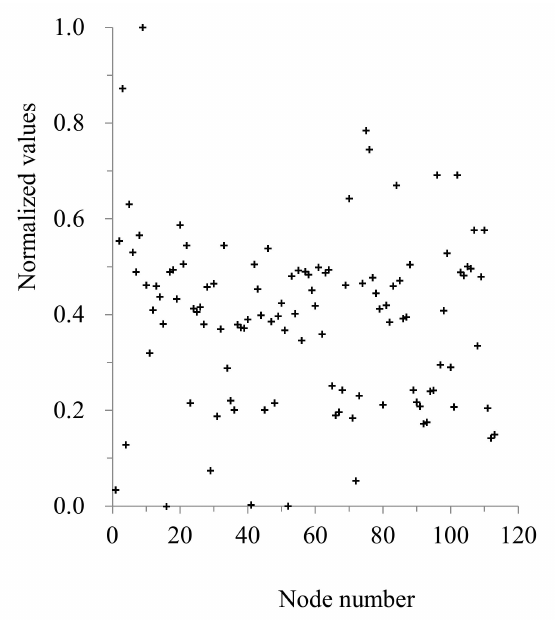
Figure 8. Normalized values of traffic loads of nodes.